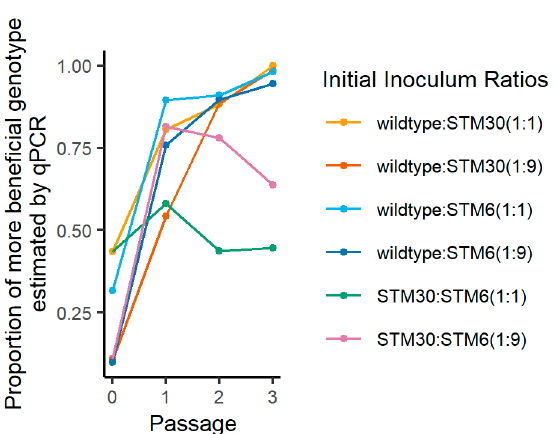
Figure 2. Change in proportion of more beneficial genotype over serial exposure to in planta growth in germination pouches. The proportion of the more beneficial genotype was estimated using qPCR at four different time points: the initial inoculation and after passage 1, 2, and 3 of in planta growth. Each combination of rhizobia genotypes had a target initial inoculation ratio of 1:1 and 1:9 (more beneficial:less beneficial). The order of benefit provided by rhizobial symbionts is wild type > STM30 > STM6.